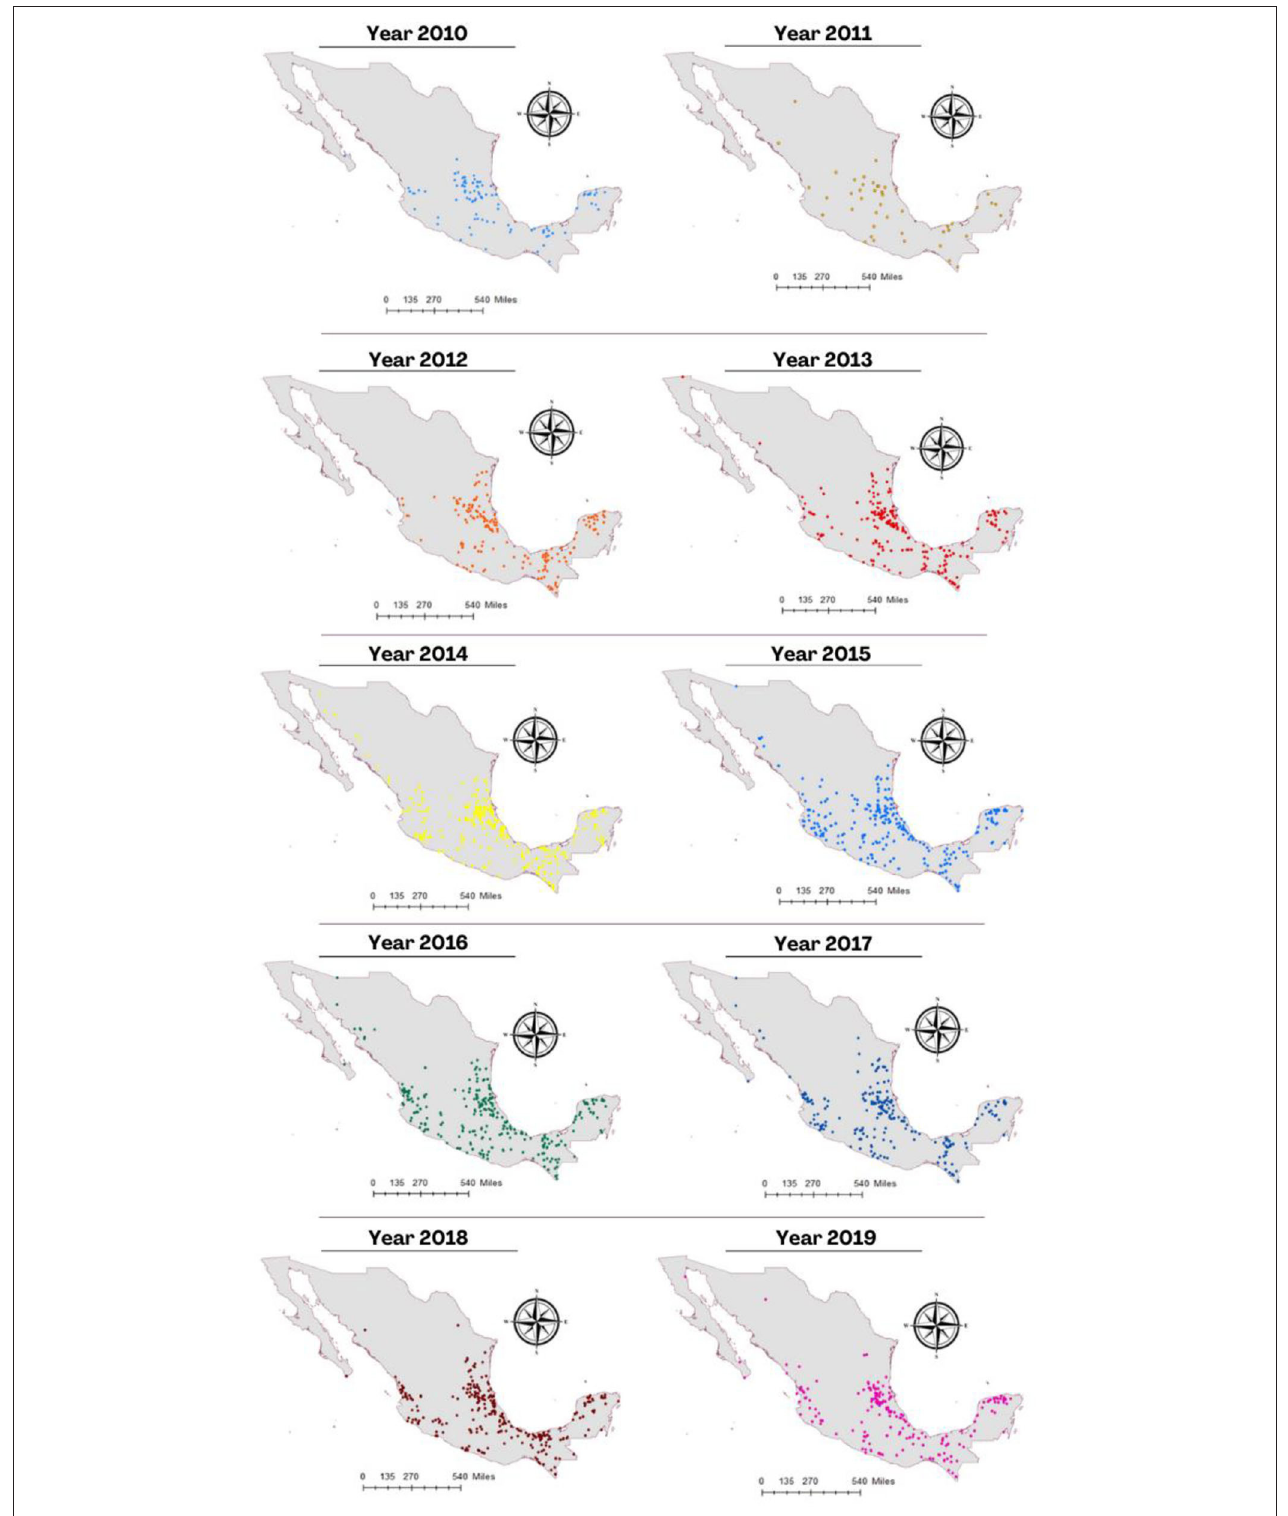
FIGURE 3 | Distribution of cases of rabies in different species animals per year during the period 2010–2019.